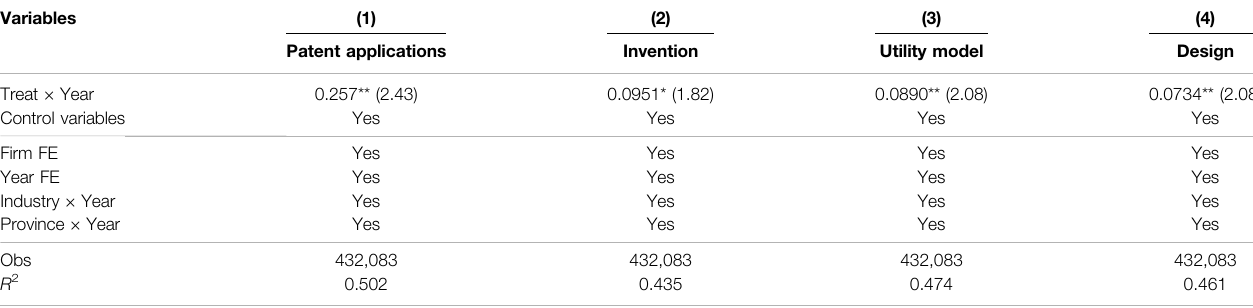
TABLE 15 | Results of the mechanism of technological innovation. Variables